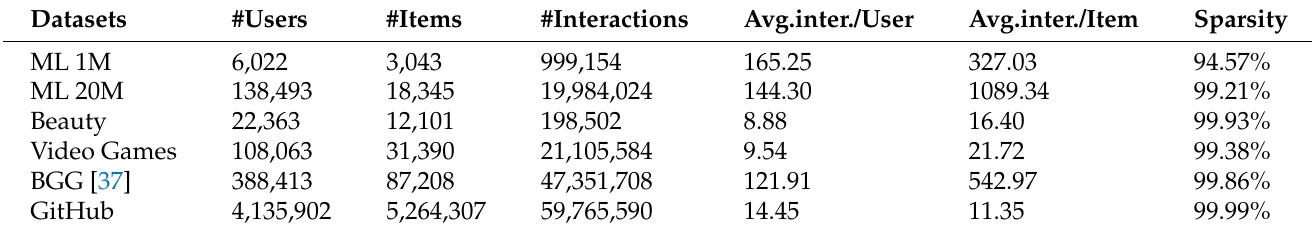
Table 2. Statistics of